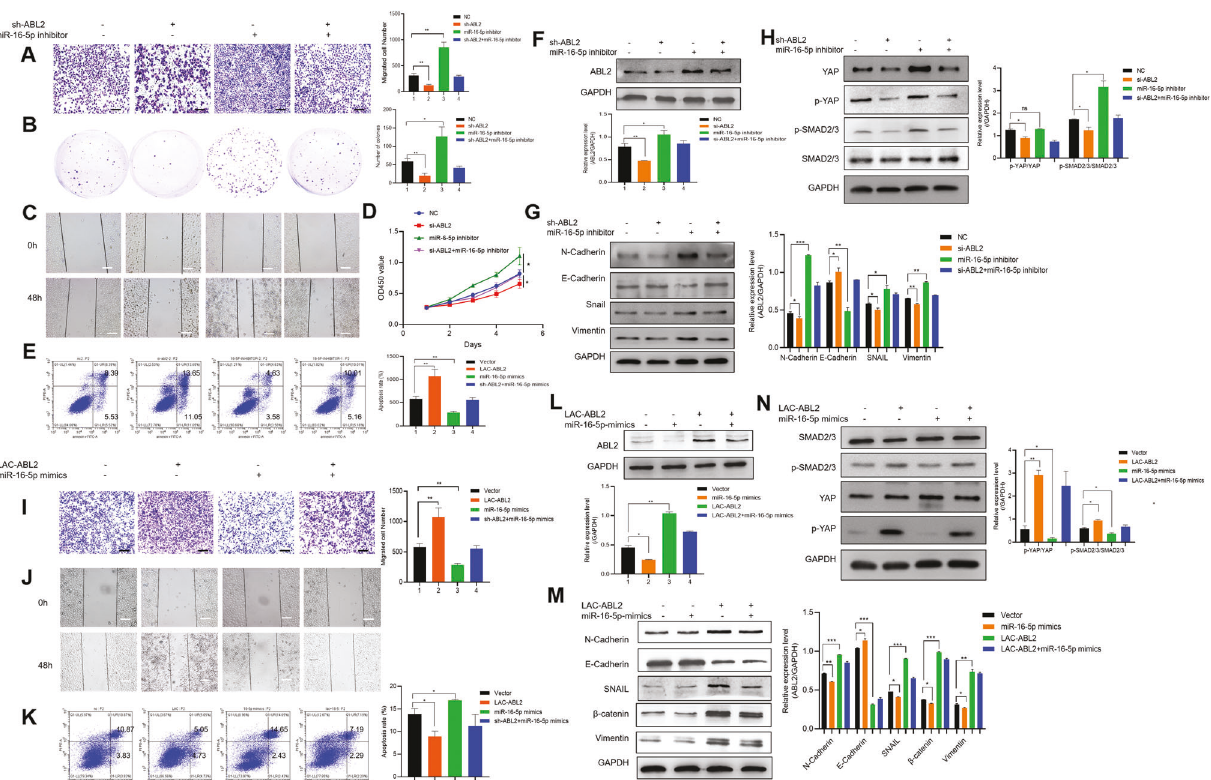
and growth, while it inhibited apoptosis, and ABL2 siRNA mitigated it. F As revealed by Western blotting assay, miR-16-5p inhibitor increased ABL2 expression. G and H ABL2 silencing within MGC-803 cells decreased N-Cadherin, Vimentin, Snail, YAP, and p-SMAD2/3 levels, while